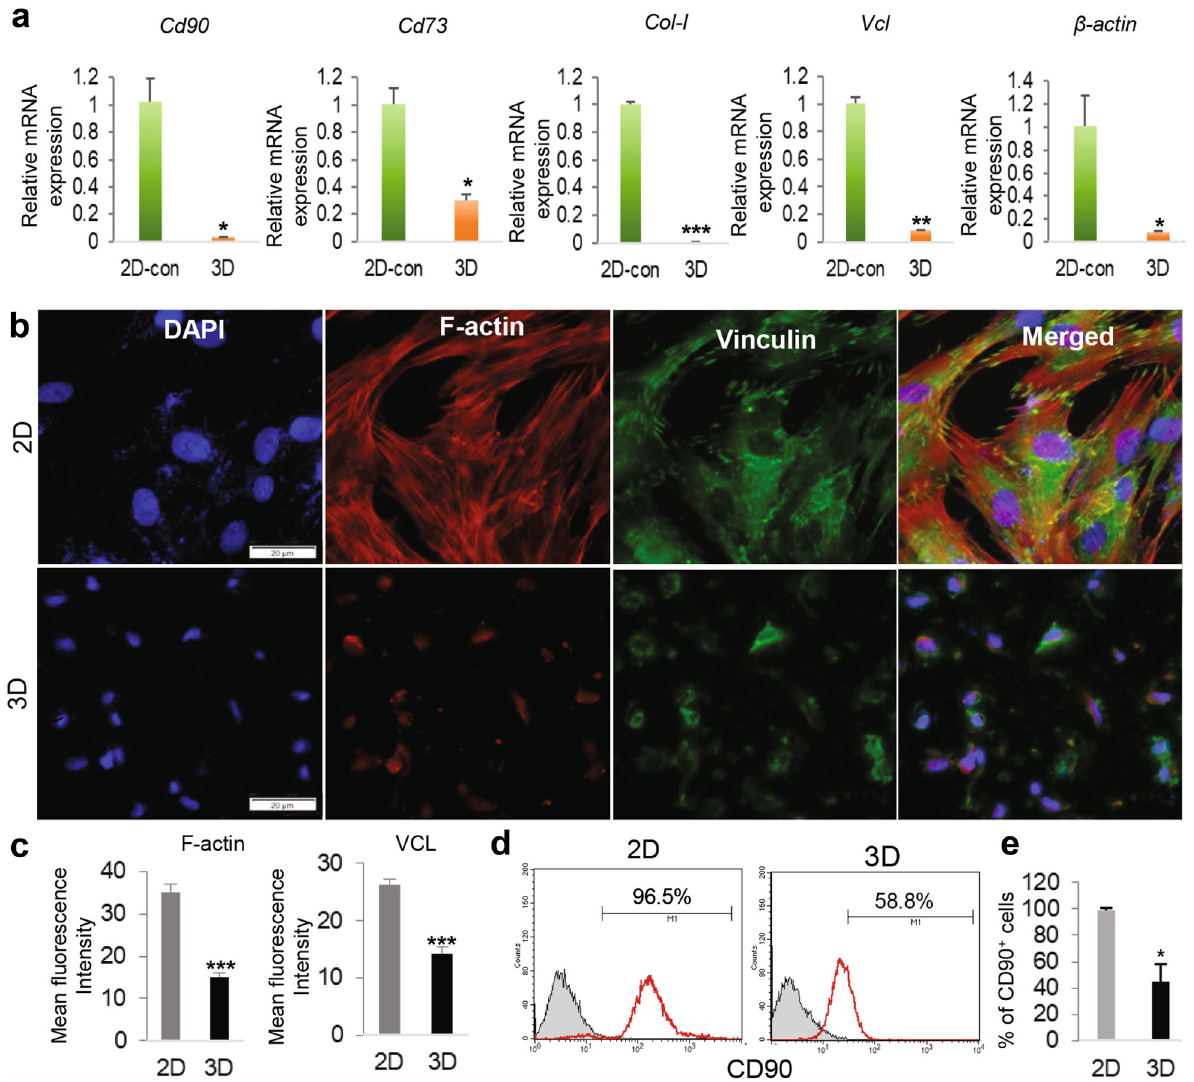
Fig. 4 Downregulation of mesenchymal cell-associated marker genes in GMSCs cultured in methacrylated 3D-collagen hydrogel. a GMSCs were encapsulated in 3D-collagen hydrogel (4 mg/mL) at a cell density of 2 × 10 6 /mL and cultured in complete α -MEM for 48 h. The mRNA expression of mesenchymal cell-associated genes, Cd90 (Thy1) , Cd73 , Col-I , Vcl , and β -actin , in 3D-cultured GMSCs was determined by quantitative RT-PCR as compared to those in 2D-cultured GMSCs. b GMSCs were cultured under 2D culture or in 3D-collagen hydrogel for 48 h. Immuno fl uorescence (IF) staining for vinculin (green color) while the cytoskeleton (F-actin) was stained with tetramethylrhodamine (TRITC)-conjugated phalloidin, a high-af fi nity F-actin probe (red). Nuclei were counterstained with 4 ′ , 6-diamidino-2-phenylindole (DAPI; blue). Scale bar = 20 µm. c Quanti fi cation of IF intensity of vinculin (VCL) and F-actin. d GMSCs were harvested from 2D-culture or recovered from 3D collagen hydrogel via digestion with collagenase I and then immunostained with speci fi c antibodies for CD90 (THY1), followed by incubation with Alexa Fluor 488-conjugated secondary antibodies. The cell samples were analyzed by a fl ow cytometer (FCM). e The average of CD90 + cells from FCM analysis. Data represent the mean ± SD, n = 3 biological replicates. * p < 0.05; ** p < 0.01; *** p < 0.001. Student ’ s two-tailed unpaired t -test ( a, c, e ). Col-I, type I collagen; Vcl, vinculin; 2D or 2D-con, GMSCs cultured in 2D-conditions; 3D, GMSC cultured in 3D-collagen